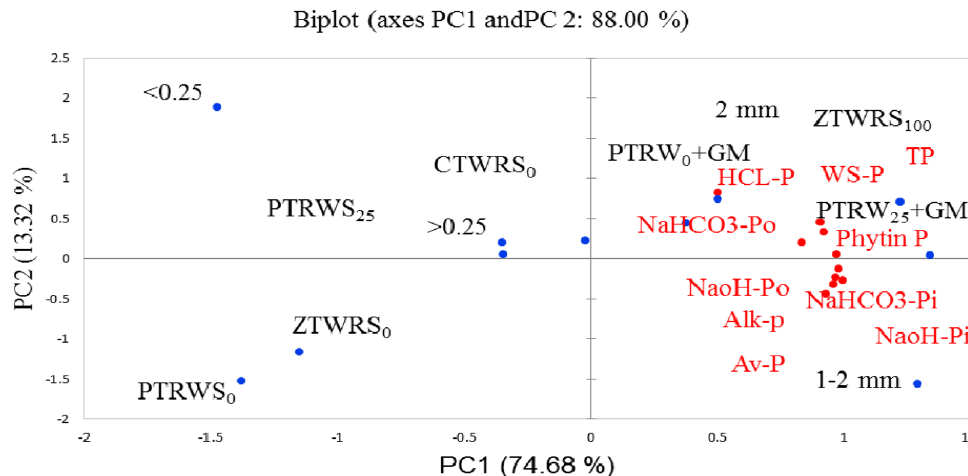
Figure 7. Principal component analysis (PCA) of assayed variables for studying the effect of tillage, crop residue management and green manure after five years of rice–wheat cropping system. PTR W0 -puddled transplanted rice with no wheat straw, PTR W25 -puddled transplanted rice with 25% anchored wheat straw retained, GM-Green manure, CTW R0 -conventional tillage wheat with rice straw removed, ZTW R0 -zero tillage wheat with rice straw removed, ZTW R100 -ZTW with rice straw retained as surface mulch.. (Acronyms: WS-P